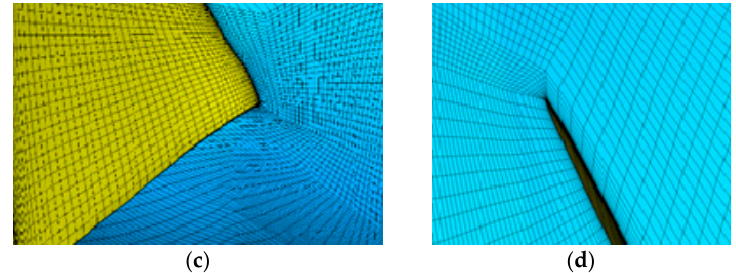
Figure 3. Grid of fluid calculation domain, ( a ) the whole calculation domain, ( b ) the main overflow components, ( c ) the root of the blade’s leading edge, and ( d ) the top of the blade’s leading edge.